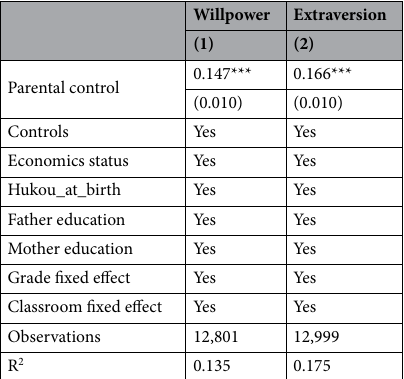
Table 14. The association between parental control and children’s